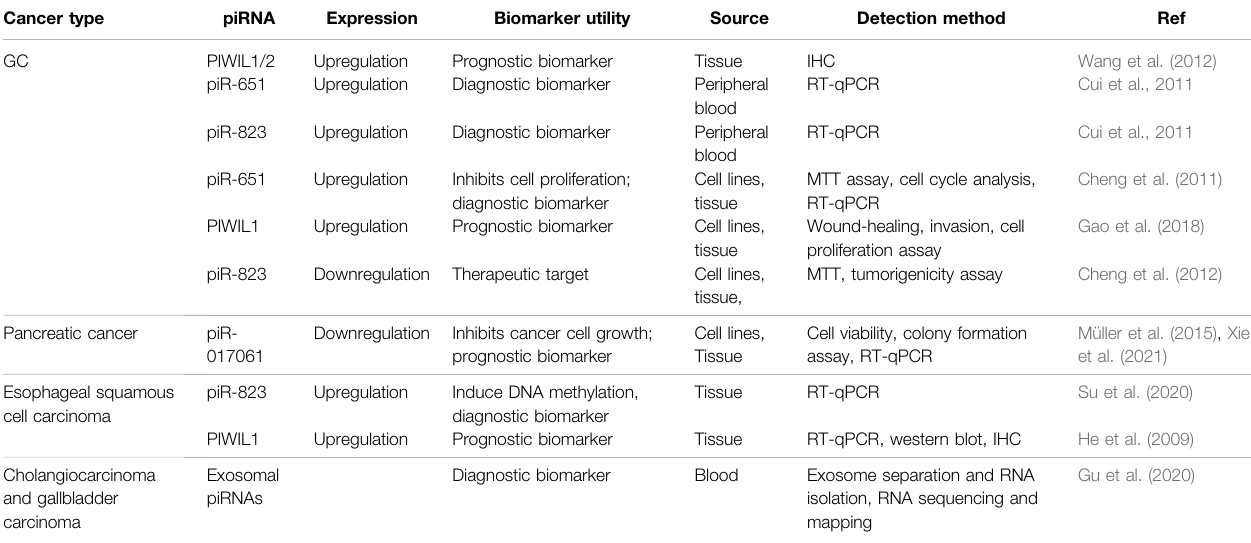
TABLE 1 | ( Continued ) Summary of piRNAs and PIWI proteins in digestive system cancers.